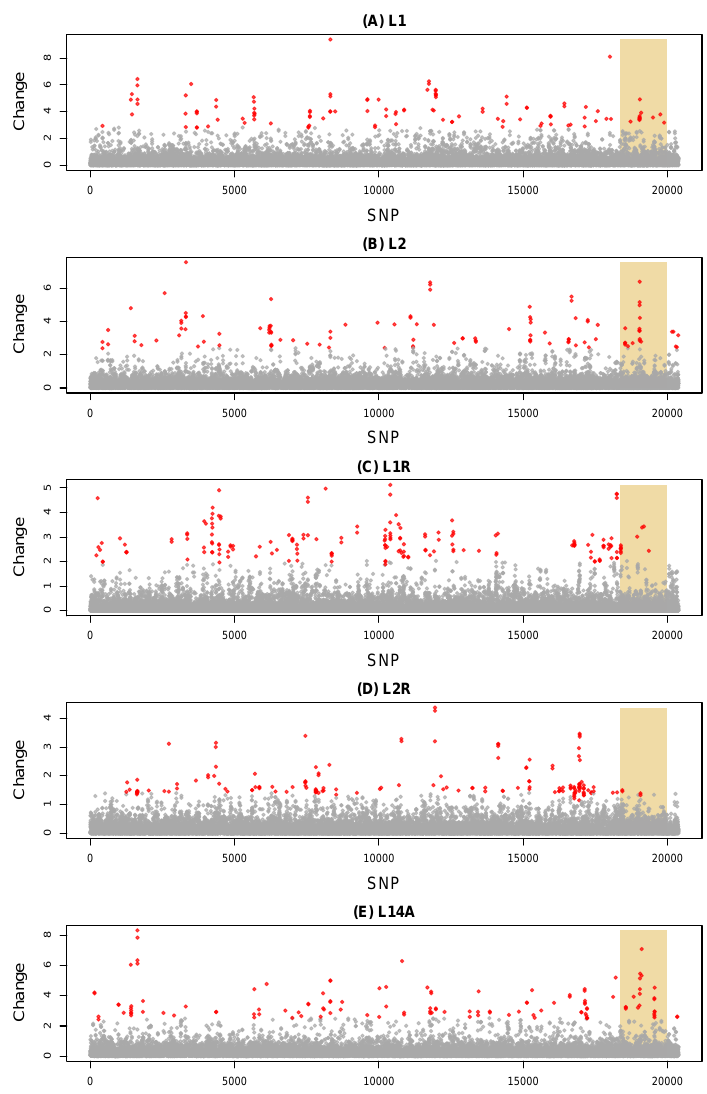
Figure 2. Manhattan plots show standardized allele frequency change for each of 20,376 SNPs for five pairs of lines and samples (that is, allele frequency change relative to the ancestral, expected heterozygosity). Results are shown for ( A ) M to L1 F100, ( B ) M to L2 F87, ( C ) L1 F91 to L1R F46, ( D ) L2 F78 to L2R F45, and ( E ) L14 P to L14A F16. Points denote change for individual SNPs, which are organized along the x-axis by scaffold and position within scaffold. The shaded region denotes putative X-linked SNPs, whereas SNPs to the left or right of this region are autosomal or Y-linked. Points are colored to reflect their hidden state from the HMM, with gray for average change and red for exceptional